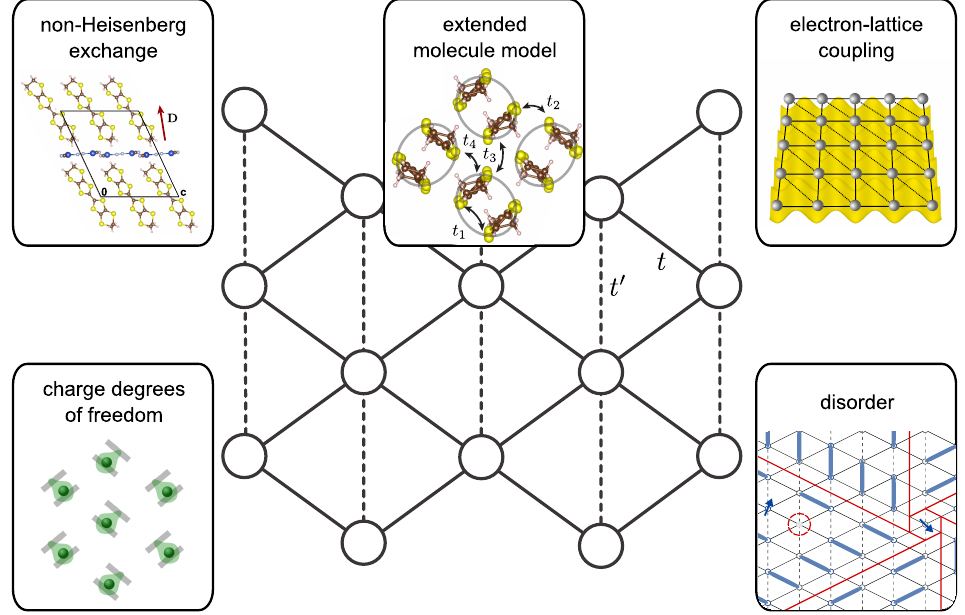
Figure 2. Center: Illustration of the mapping of the organic layer of κ phase charge-transfer salts to an anisotropic triangular lattice. The various ingredients for generalized models beyond the strongly dimerized one-band Hubbard picture discussed in this work are illustrated in the